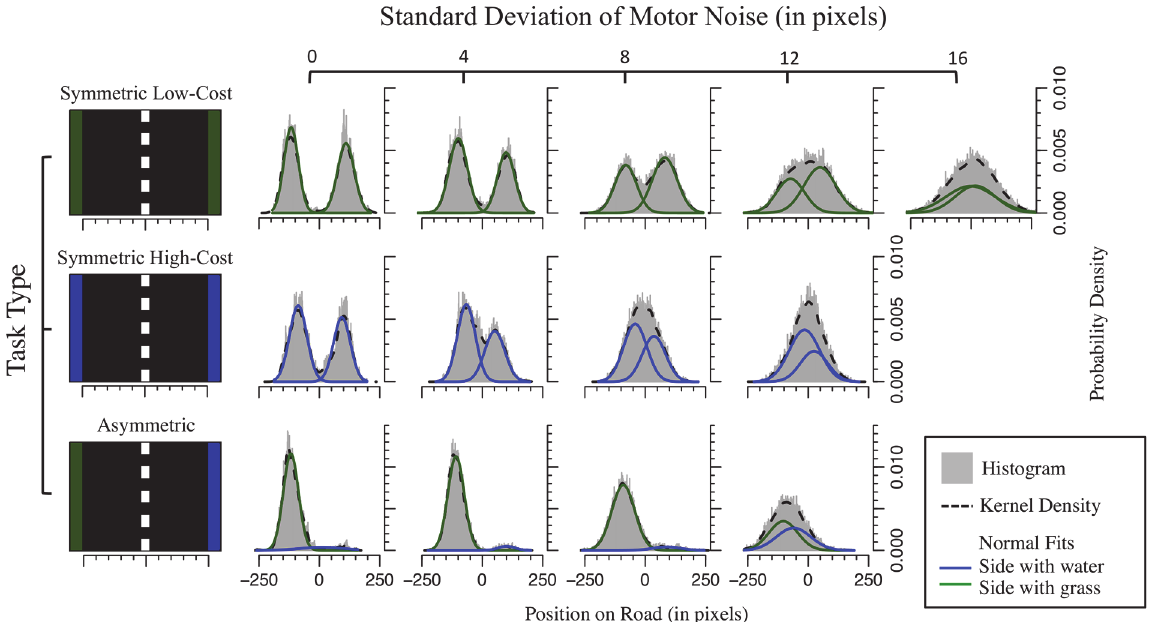
Fig 3. Raw Population position data. Plots are the histograms of the pooled subject data for each task type (by row) and uncertainty level (by column). The dashed lines are the kernel densities of the data and the solid lines are the bimodal Gaussian fits (see methods). Green lines represent the position Gaussian near grass (low-cost) while blue represents a position peak near water (high cost). In the asymmetric task, the bottom row, it can be seen that subjects maintained a position far away from the side with water. The x-axis represents the position of the center of the car on the road in pixels. (The road is 500 pixels wide, and the car is 40 pixels, so the subject ran off the road at ± 230 pixels.) These images depict a trend similar to Fig 1. As the outer boundary costs increased, the subjects moved toward the center of the road. Similarly, as the standard deviation of uncertainty increased, subjects also moved toward the center of the road.